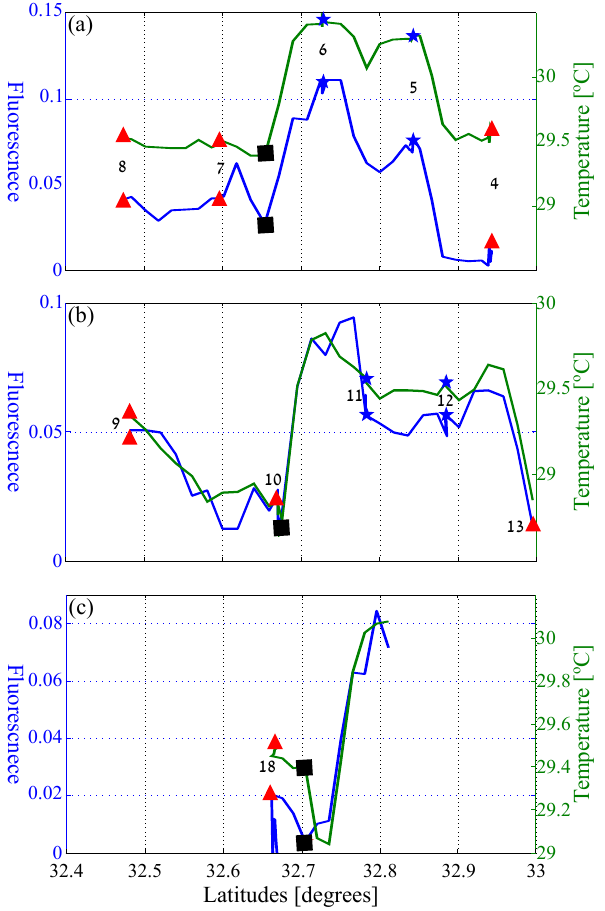
Fig. 4. In situ measured surface temperature (green) and fluores- cence (blue, arbitrary unit) along three meridional sections orthog- onal to the patch’s main axis (dashed white lines and corresponding letters in Fig. 3). Blue stars and red triangles mark the locations of sampling stations in and out of the patch, respectively. Numbers de- note station names. The black square marks intersection with the southern dynamic patch boundary (DPB), associated with the at- tracting LCS adjacent to the patch’s southern edge. Note the change in scale between the different panels.